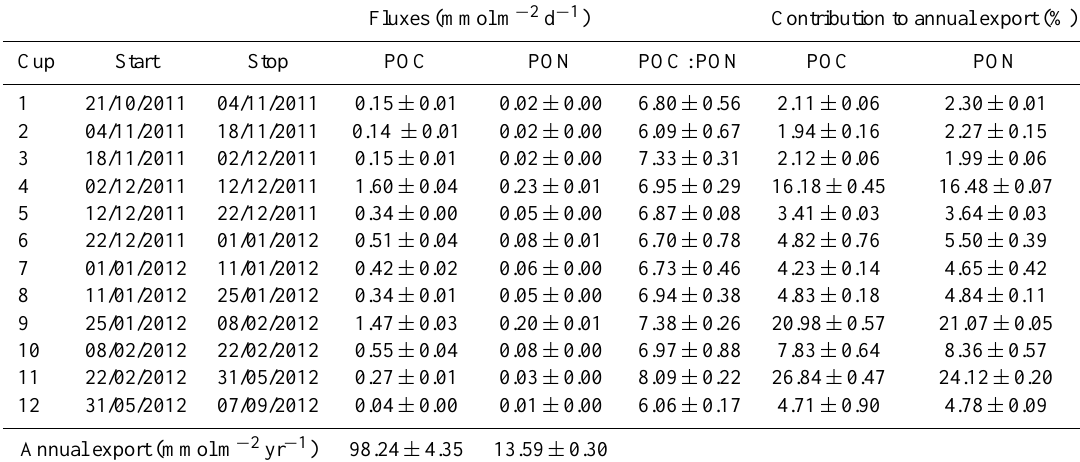
Table 1. Dynamics of carbon and nitrogen export fluxes at station A3 collected by the sediment trap at